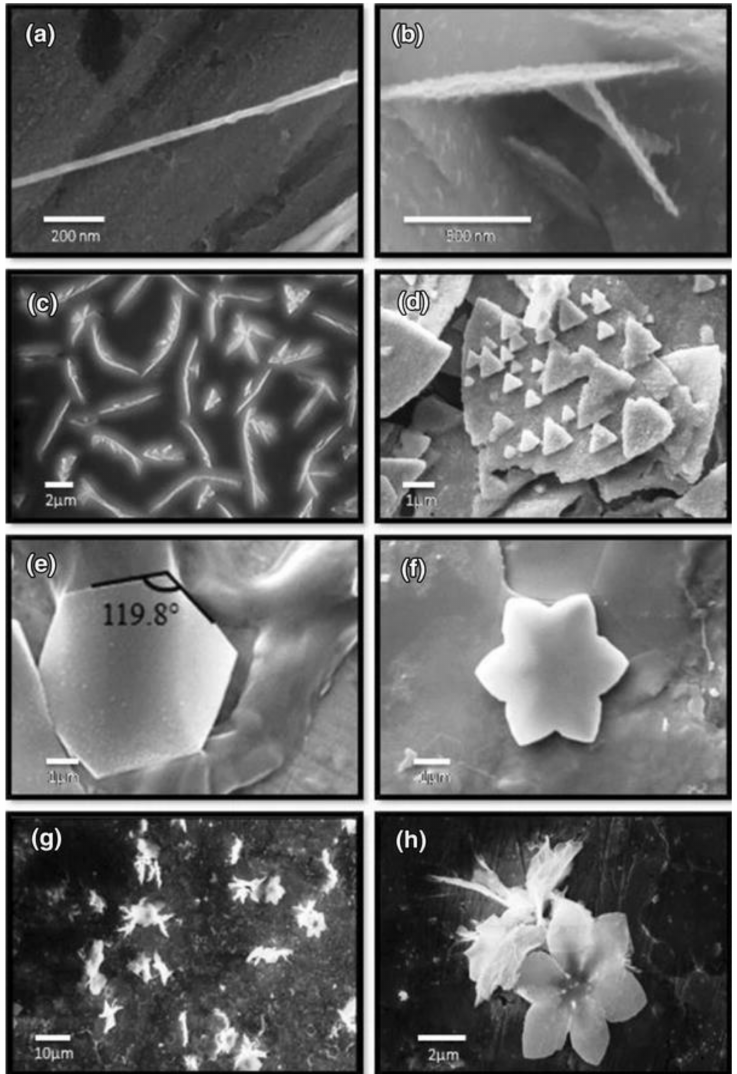
Figure 10. SEM photomicrographs of DNA composites ( a ): DNA-water-soluble carbon nano-onion (wsCNO) at 1 h; ( b ): Growth at 4 h; ( c ): Aggregation at 4 h; ( d ): Triangle formation at 16 h; ( e ): Hexagon formation; ( f ): Flower formation; ( g ): Assorted flower formation; ( h ): Selected six-petal flower